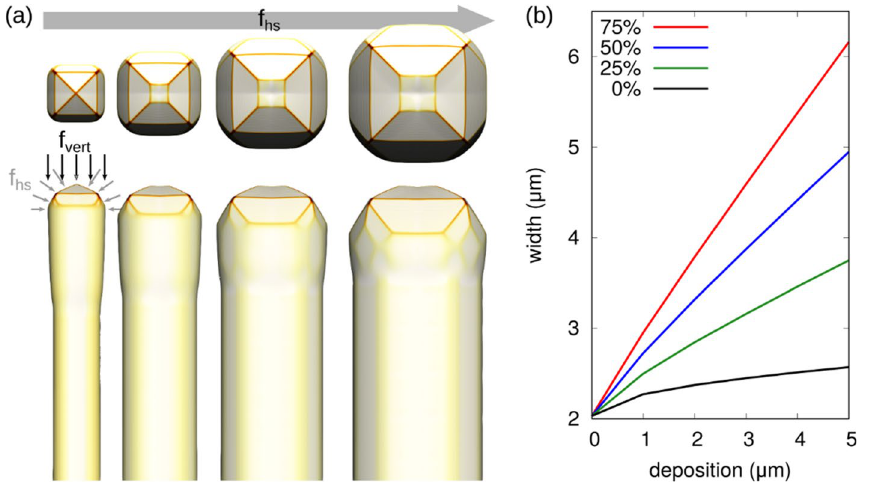
Figure 2. The effect of the distribution of the deposition flux on the crystal facets. ( a ) Simulated morphologies: from left to right, the hemispheric component f hs of the flux is increased from 0% up to 75% by 25%